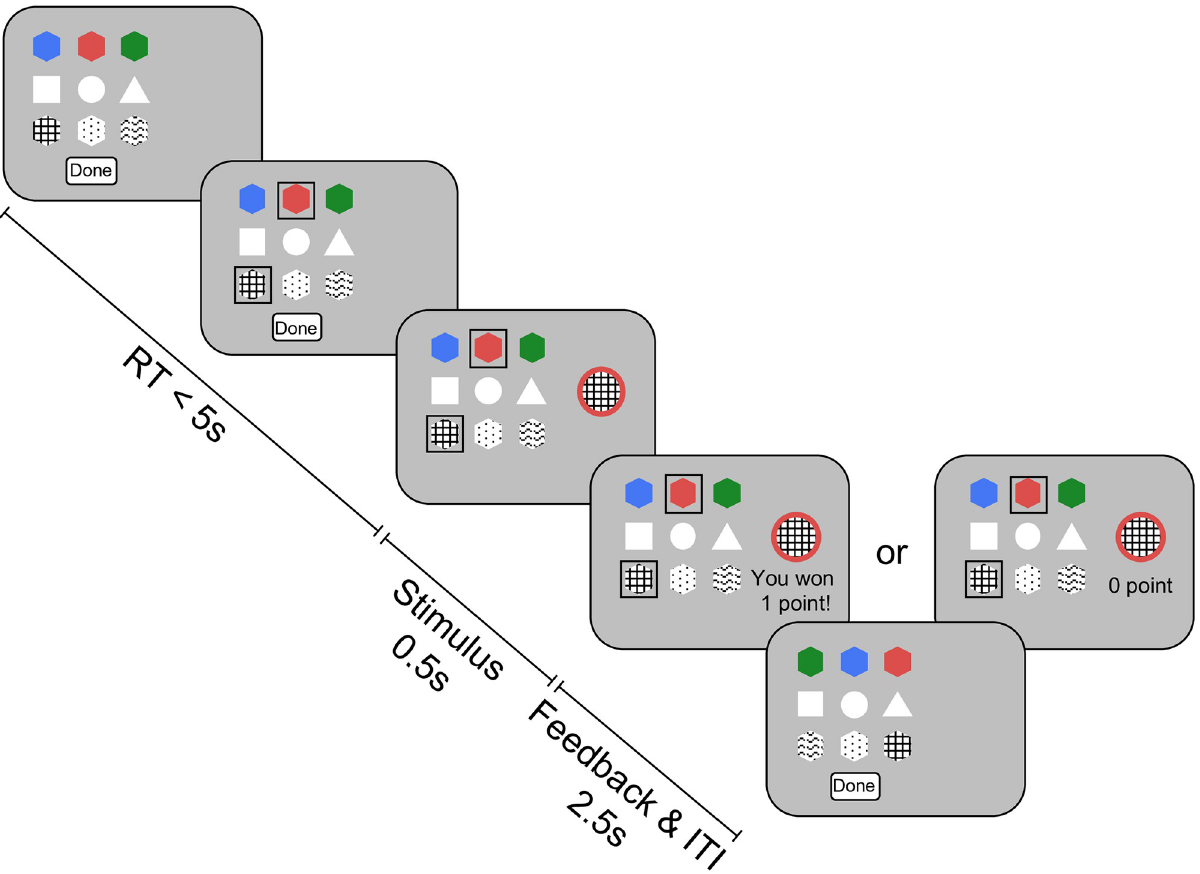
Fig 1. The “build your own icon” task. Participants built stimuli by selecting a feature in zero to three dimensions (marked by black squares). After hitting “Done”, the stimulus showed up on the screen, with features randomly determined for any dimension in which participant did not make a selection (in this example, circle was randomly determined). Reward feedback was then shown.